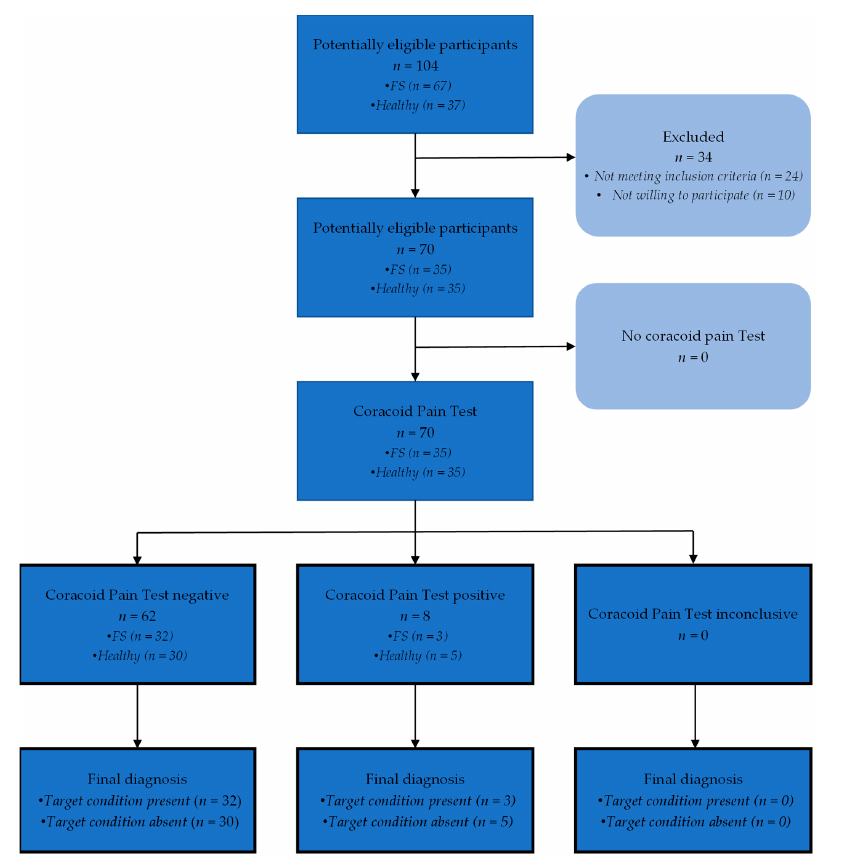
Figure 2. Participant flow of the study. FS: frozen shoulder. Table 2. Group characteristics of the included participants.